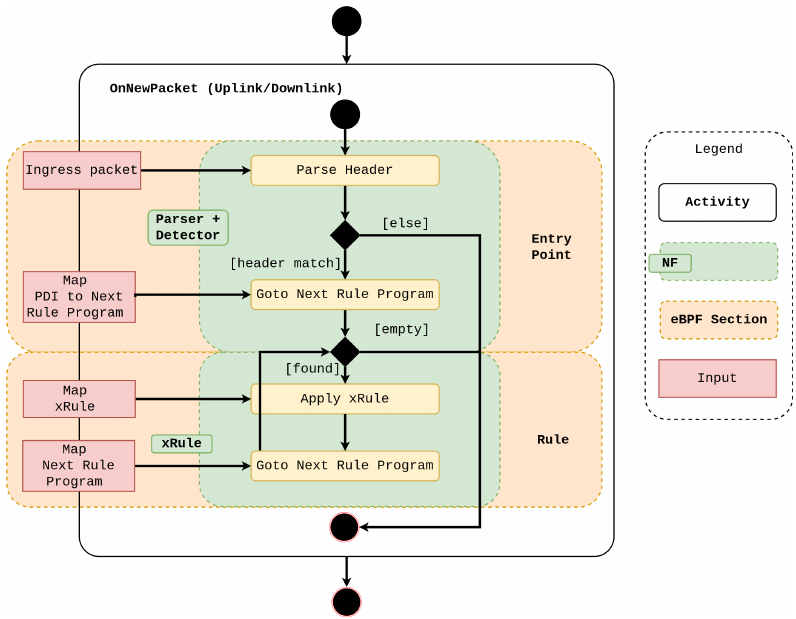
Figure 14. On new packet activity diagram with the decoupled rules (version